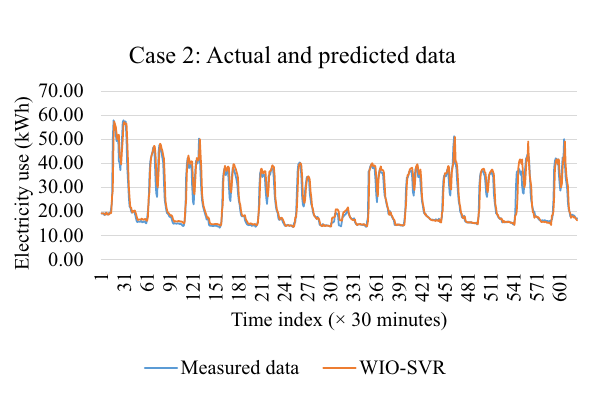
Figure 10. Actual and predicted data for case 2.